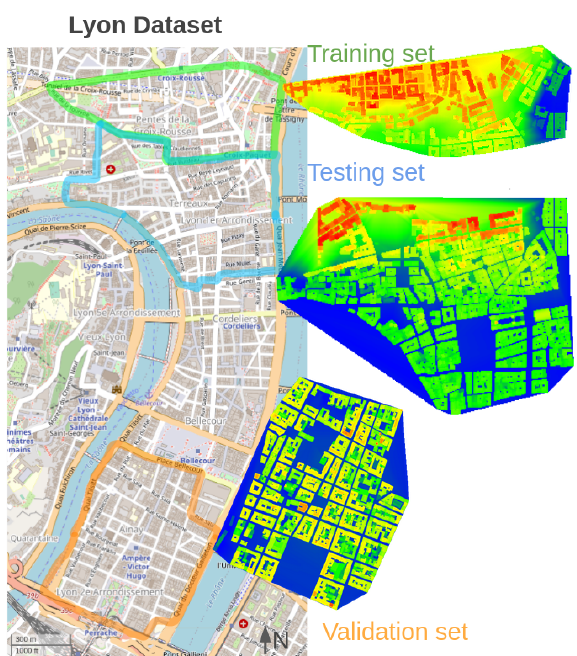
Figure 2. Lyon dataset split into 3 distinct parts: training, validation and test sets. Elevation is shown in color and is relative to each subset.